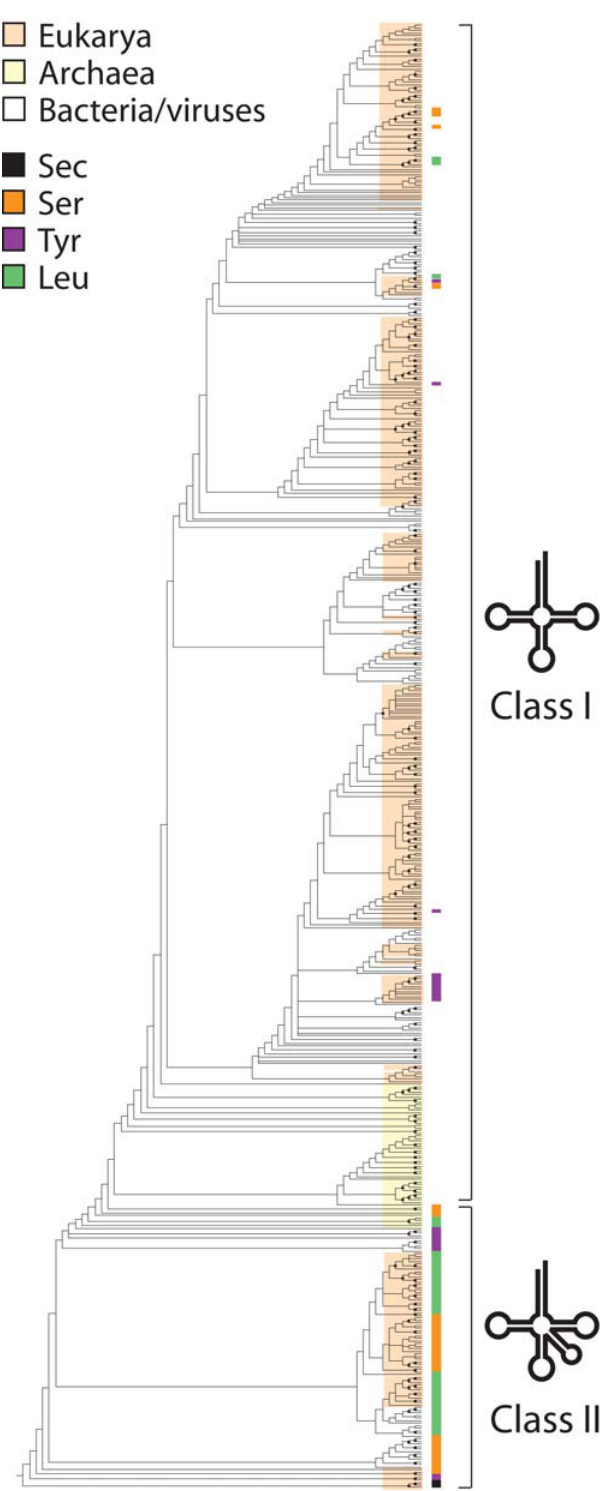
Figure 1. A global phylogenetic tree of tRNA molecules reconstructed from sequence and structure. MP analyses of data from 571 tRNA molecules resulted in the preset limit of 20,000 minimal length trees, each of 10,083 steps. Consistency index (CI)=0.069 and 0.069, with and without uninformative characters, respectively; Retention index (RI)=0.681; Rescaled consistency index (RC)=0.047; g1= 2 0.107. Terminal leaves are not labeled since they would not be legible. Nodes labeled with closed circles have BS values . 50%.